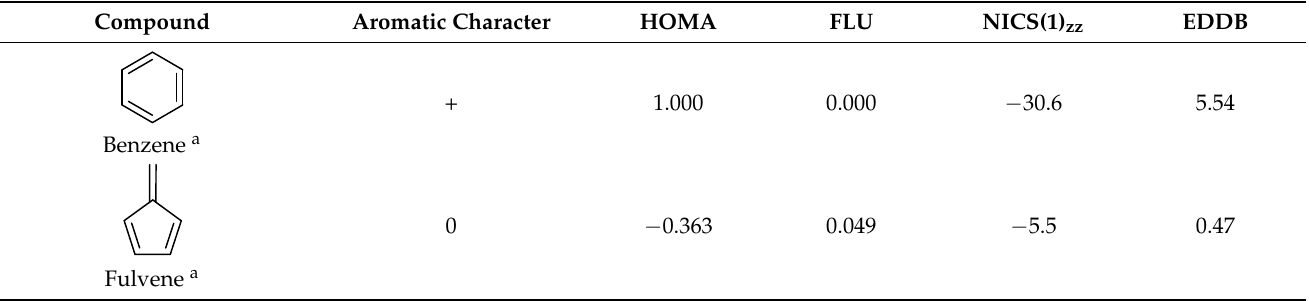
Table 3. Values of aromaticity indices for several aromatic (+), anti-aromatic ( − ), and non-aromatic (0) monocyclic molecules: geometric (HOMA), electronic (FLU and EDDB), magnetic (NICS(1) zz ).